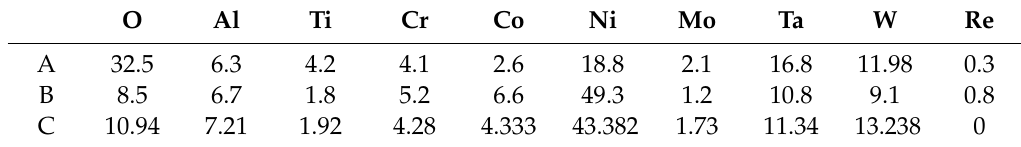
Table 3. EDS results of the sample surface after anodic polarization at 20 °C.